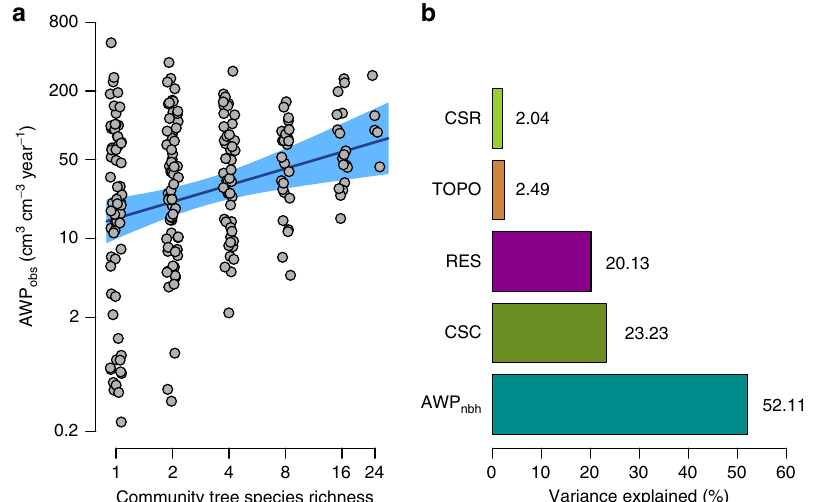
Fig. 2 Biodiversity effects on community productivity. a Biodiversity – productivity relationship at the community scale. The solid blue line corresponds to the fi tted relationship of a mixed-effects model, with the shaded area representing the 95% con fi dence interval of the prediction. Points represent observed values of standardised aboveground wood productivity (AWP obs ) for each individual plot ( n = 234; site B). Plot-speci fi c values are jittered to facilitate visibility, and axes are logarithmic. b Biotic and abiotic drivers of the community biodiversity – productivity relationship. Variance partitioning for four predictors: community (i.e., at the plot level) tree species richness (CSR) and composition (CSC, speci fi ed as random effect), community productivity based on neighbourhood inteactions (AWP nbh ) and heterogeneity in topography (i.e., variation in elevation, TOPO). Bars and numbers next to the bars correspond to the fraction of variance explained by each predictor of a linear mixed-effects model, and the variance not explained by the model (the residual,